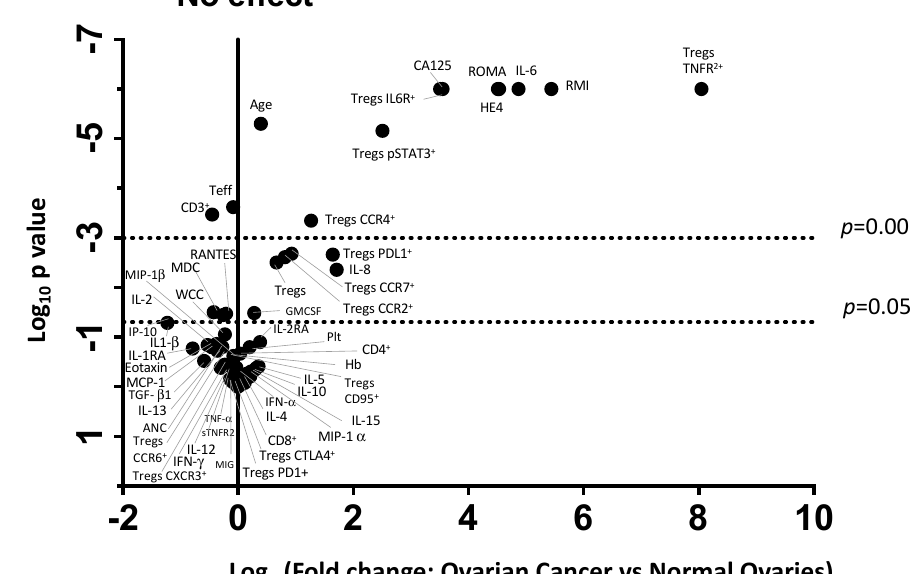
Log (Fold change: Ovarian Cancer vs Normal Ovaries) 2